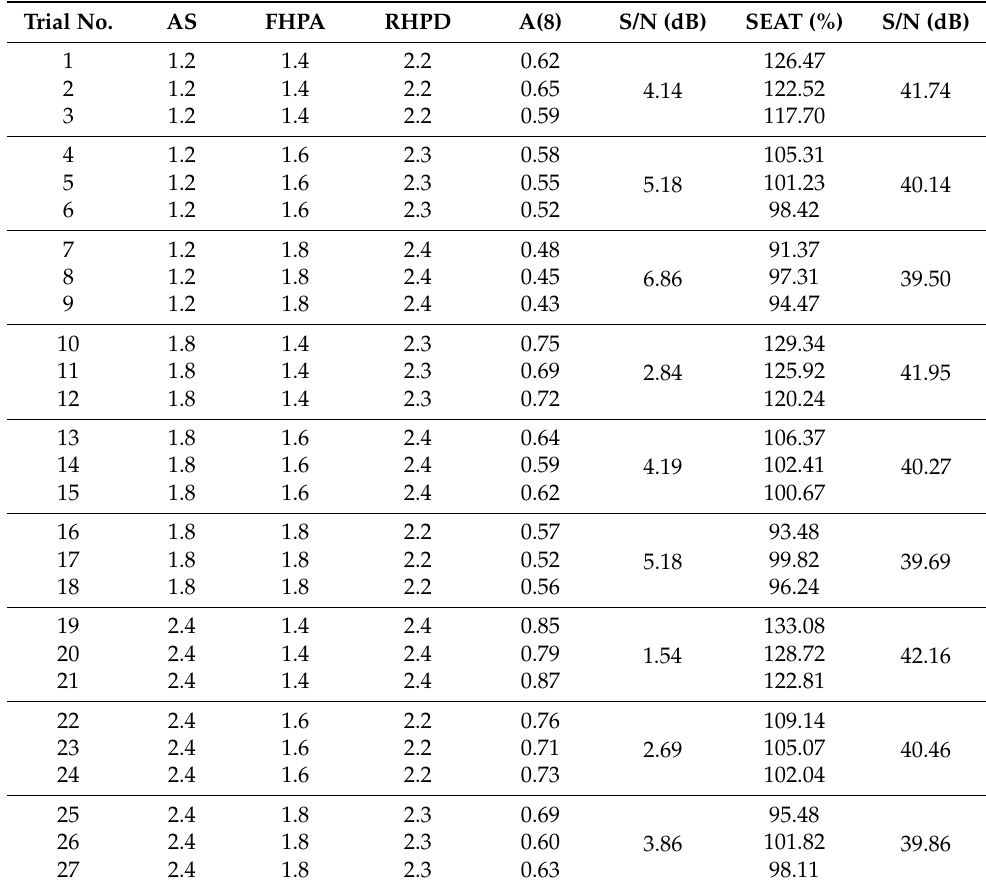
Table 2. S/N ratio response for A(8) &